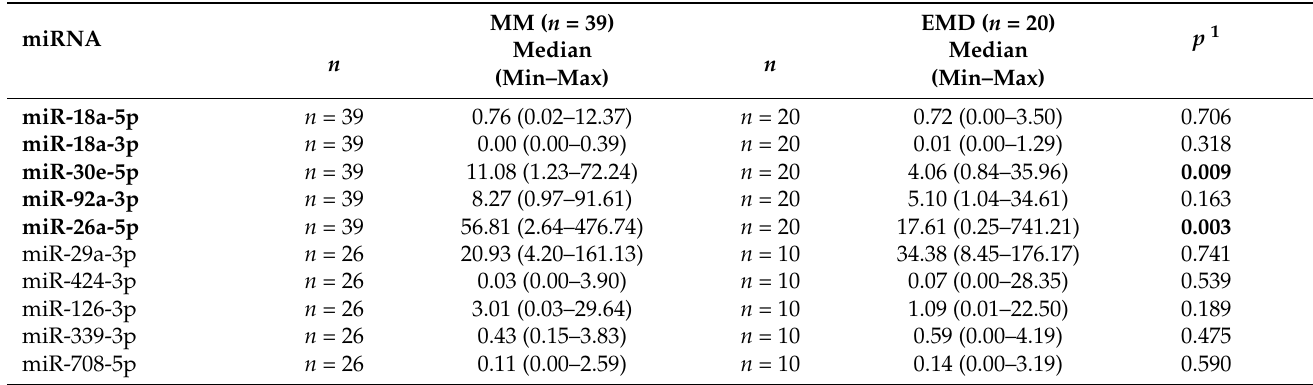
Table 3. Normalized expression levels of selected microRNAs (miRNAs) in validation phase of the study.